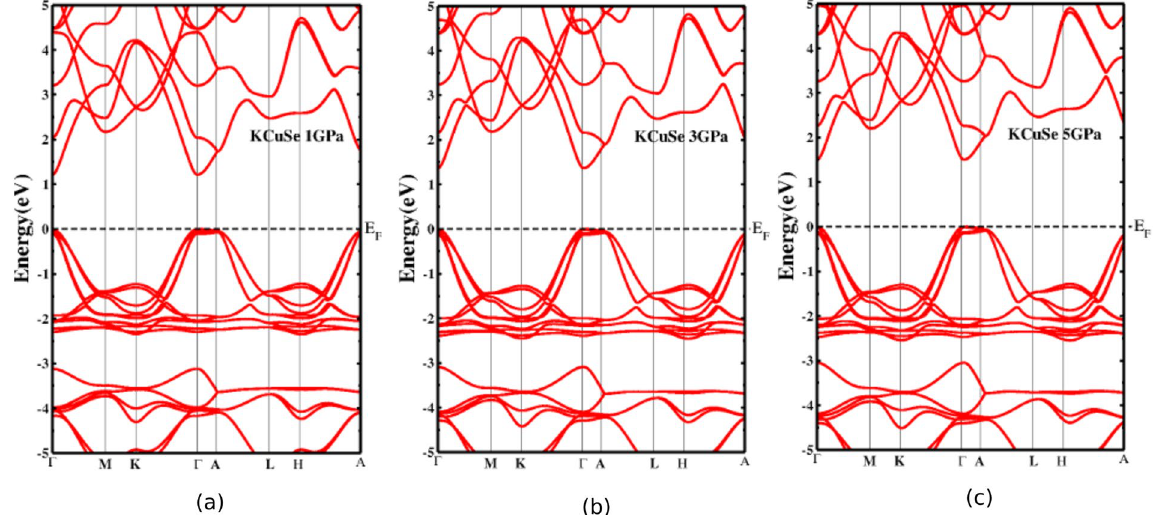
Figure 6. Effect of pressure on band structures of KCuSe at ( a ) 1 GPa ( b ) 3 GPa and ( c ) 5 GPa by using TBmBJ potential and incorporating SOC.